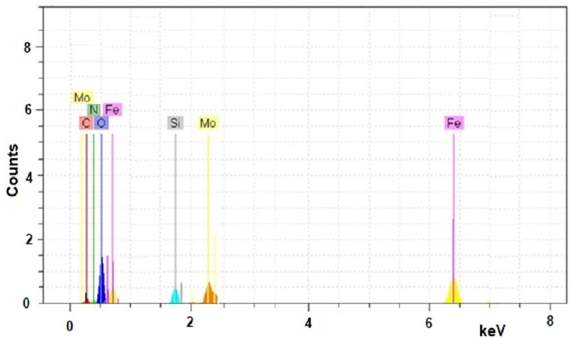
Figure 4. EDX of the Fe 3 O 4 /GO/[FeMo 6 ].